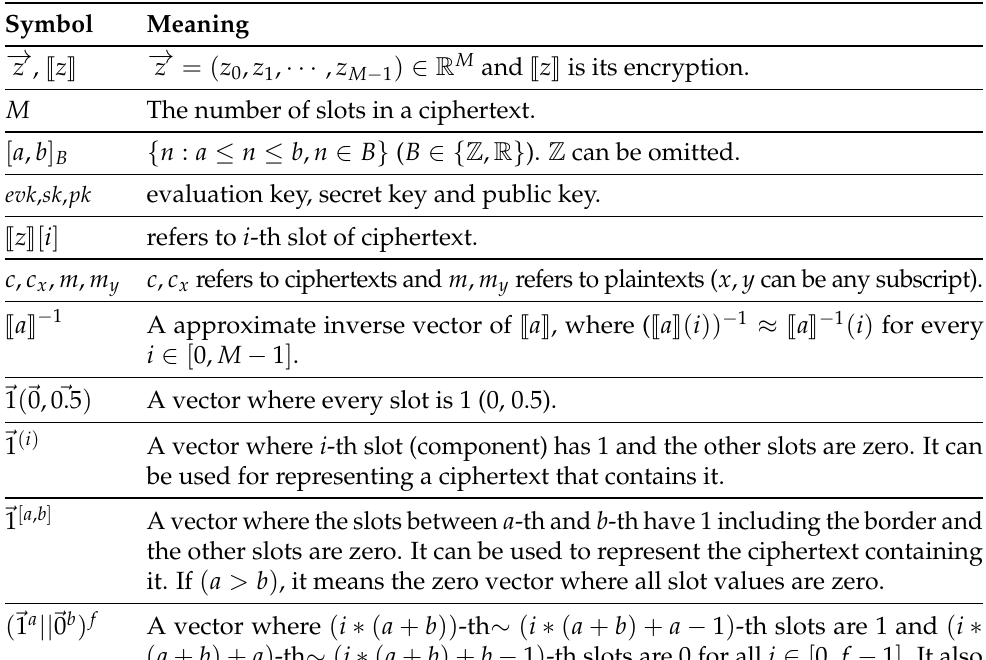
Table 1. Notations and